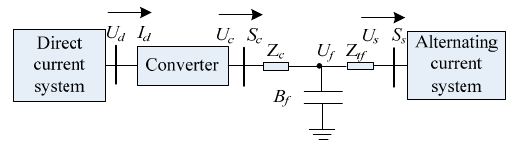
Figure 1. The steady state model of voltage source converter-multi terminal direct current (VSC-MTDC).